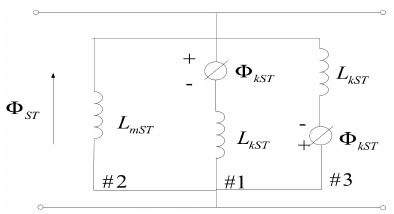
Figure 4. Flux–current circuit model of the